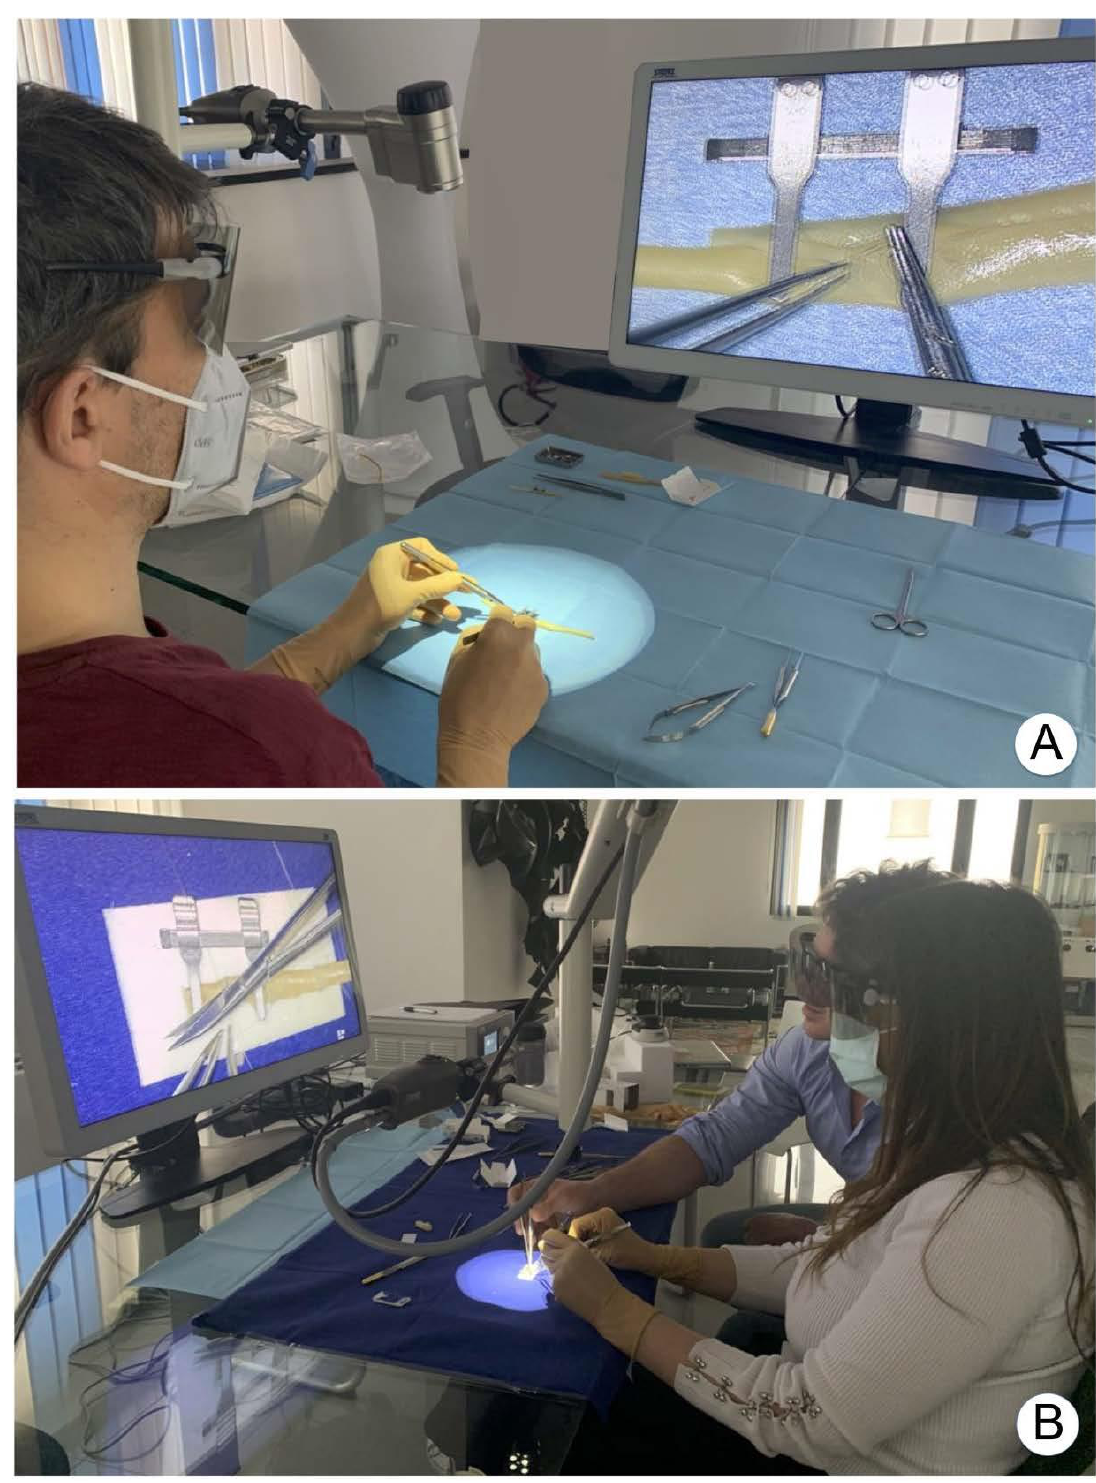
Figure 4. Posture and freedom of movement of the surgeons is shown. ( A ). Single operator ( B ). Possibility for two operators, during a microsurgical course to sit next to each other and share the same view.